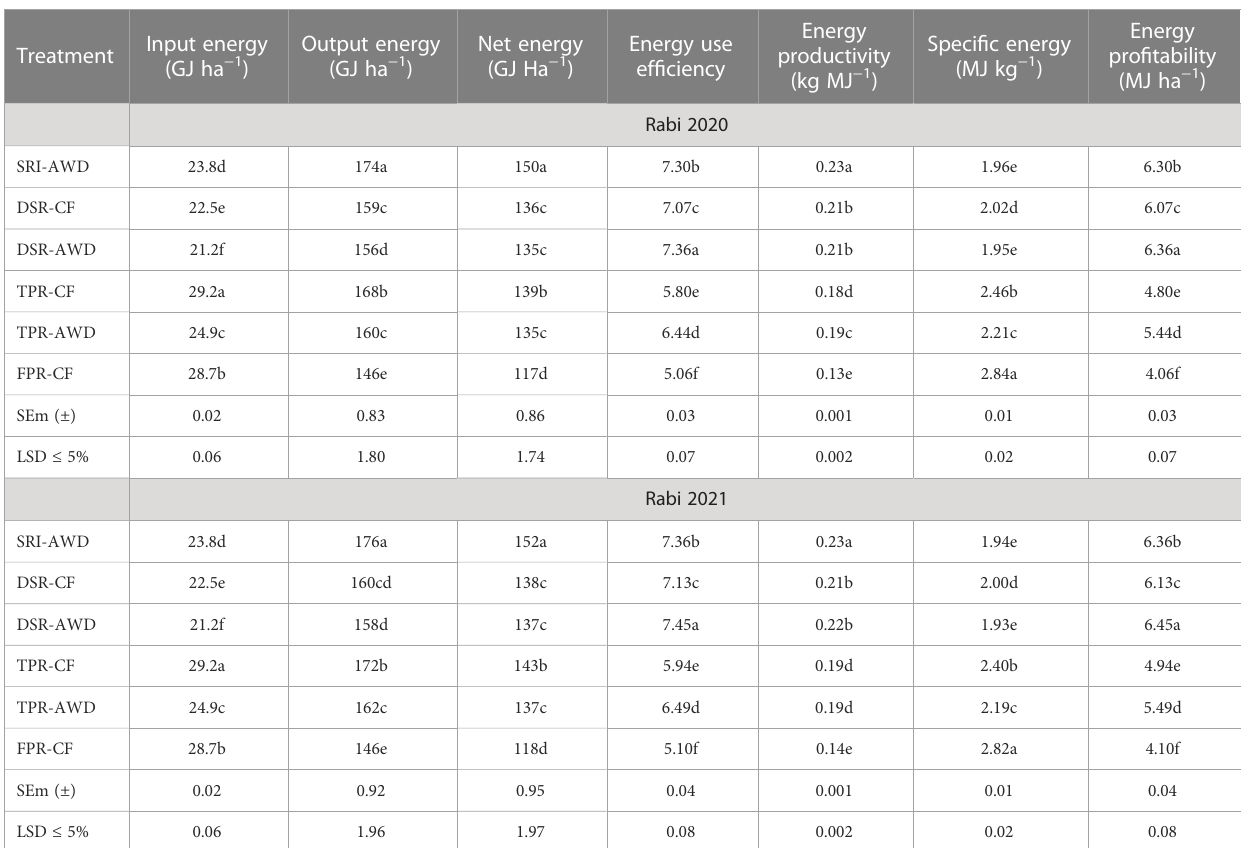
TABLE 4 Energy input – output relationship of rice crop as in fl uenced by different rice production techniques.